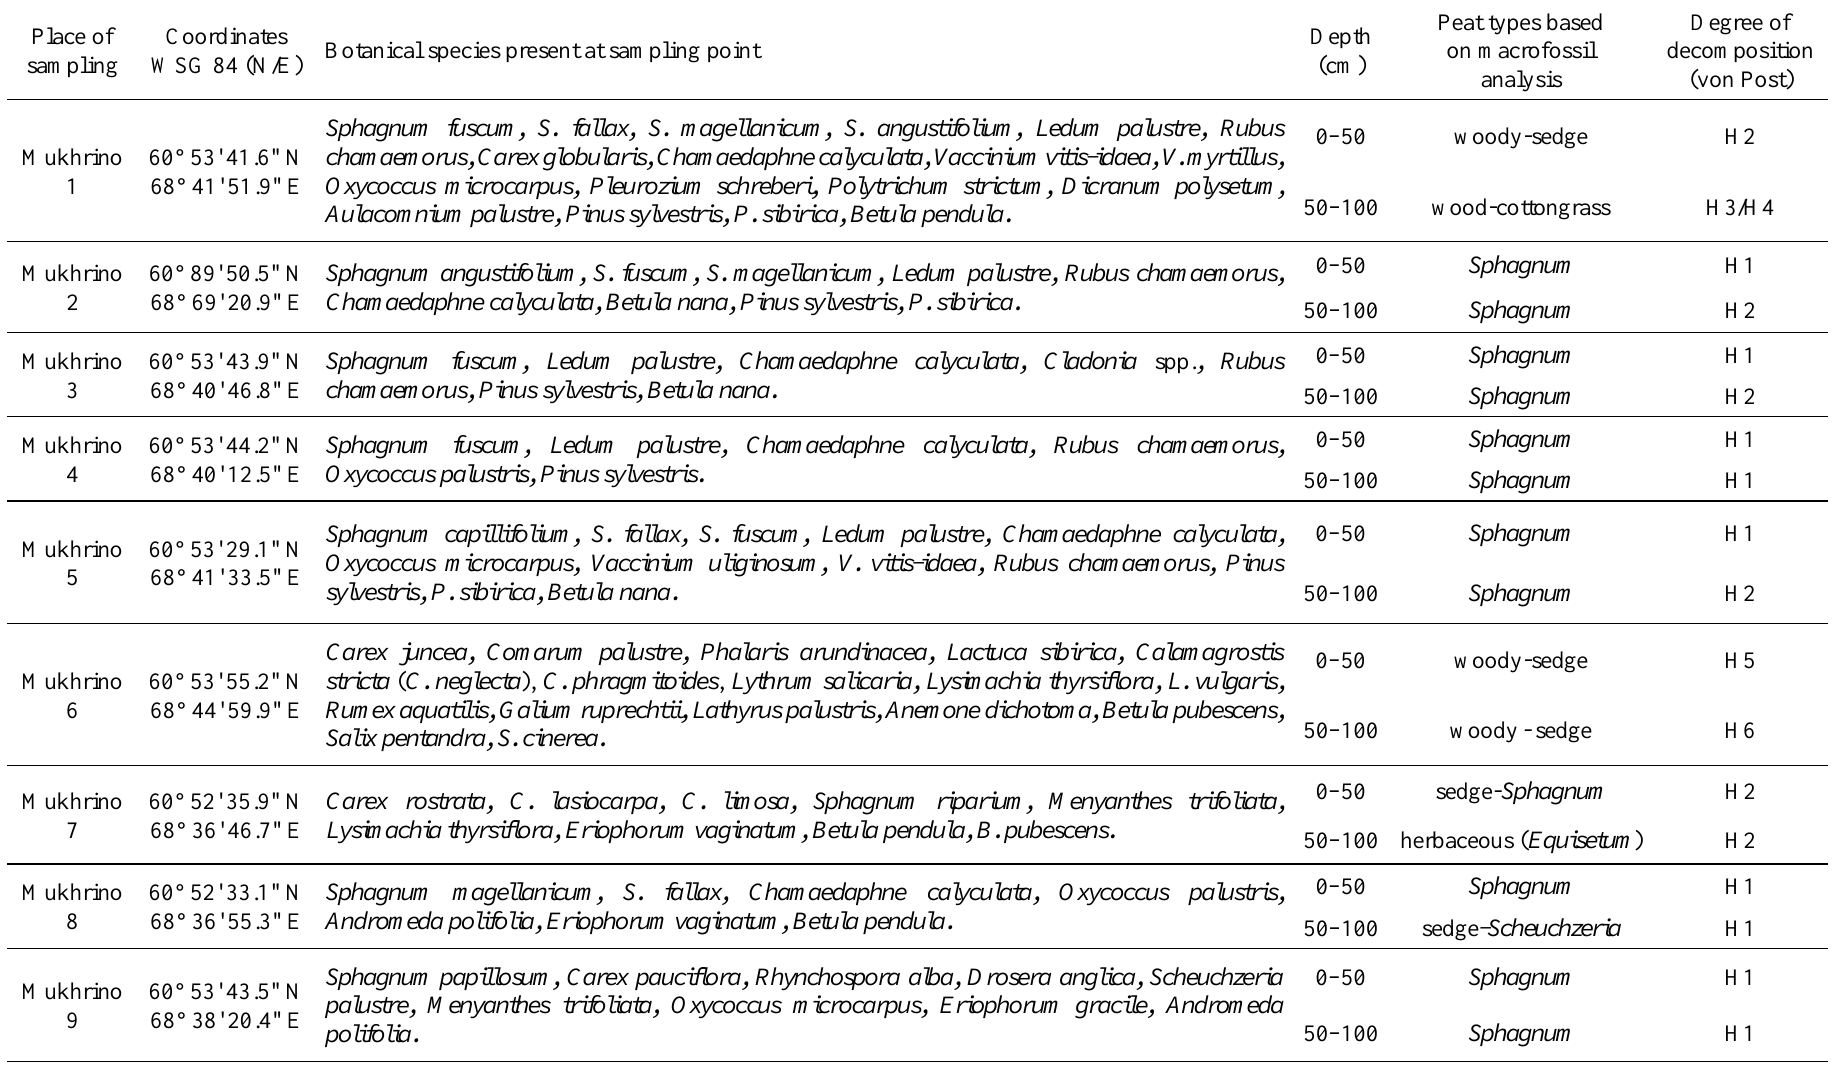
Table 2. Sampling locations for Mukhrino peatland (Russia), including botanical composition of vegetation cover and peat stratigraphy. Place